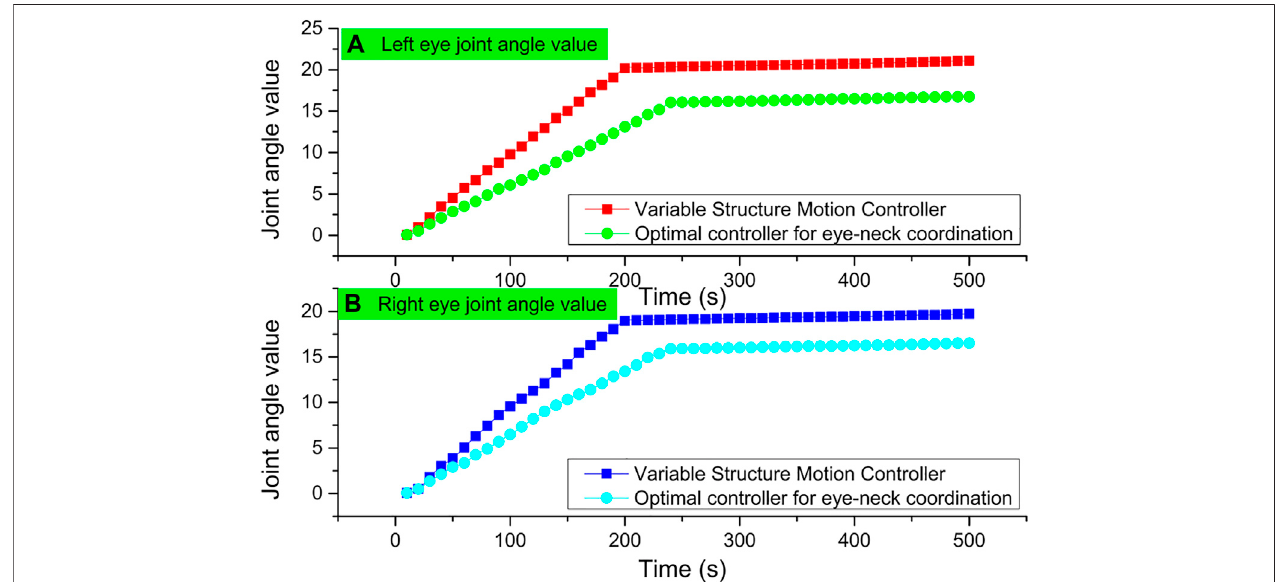
FIGURE 5 | Variable structure controlled stationary target tracking